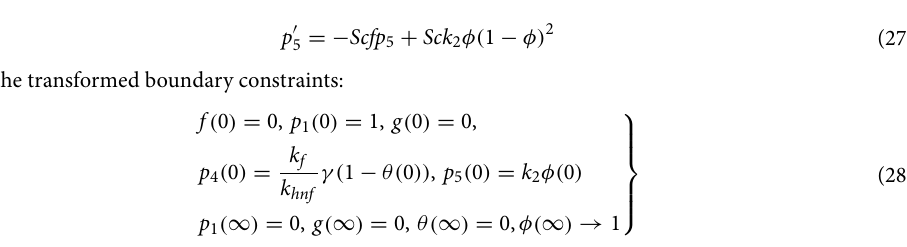
Figure 2. ( a ) Graphical illustration of velocity f ′ against M . ( b ) Graphical illustration of velocity f ′ against α . ( c ) Graphical illustration of velocity f ′ against φ 1 = φ 2 . ( d ) Graphical illustration of velocity f ′ against (cid:31)